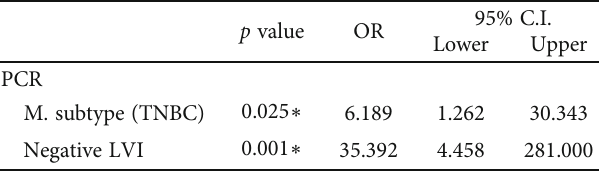
Figure 3: ROC curve analysis to de fi ne the cut of point of Ki67%. Table 6: Logistic regression analysis de fi nes triple negative subtype and negative lymphovascular invasion as best predictors of